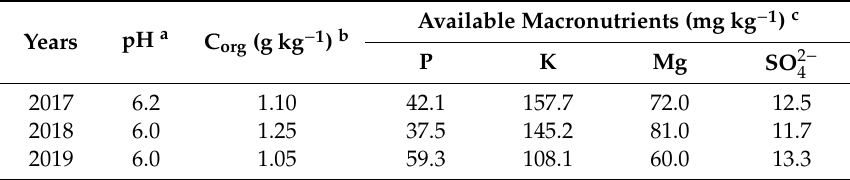
Table 1. Chemical properties of the analyzed